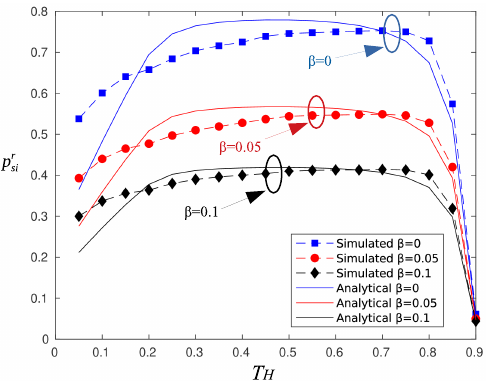
Figure 4. Probability of successful information reception p r